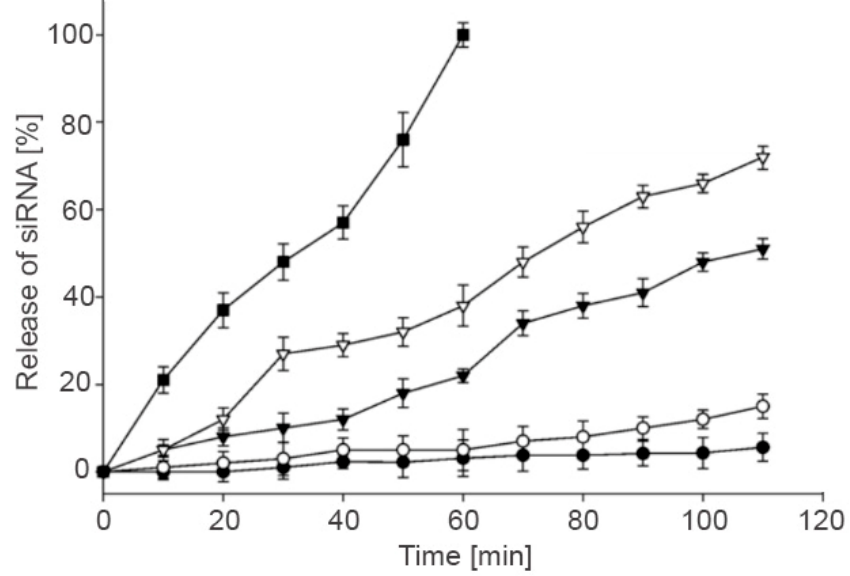
Figure 5. Release of siRNA from thiolated HA gels at various glutathione concentrations; ( ● ) 0 mM GSH, ( ○ ) 0.1 mM GSH, ( ▼ ) 1 mM GSH, ( ▽ ) 5 mM GSH and ( ■ ) 10 mM GSH. Adapted from Lee et al.